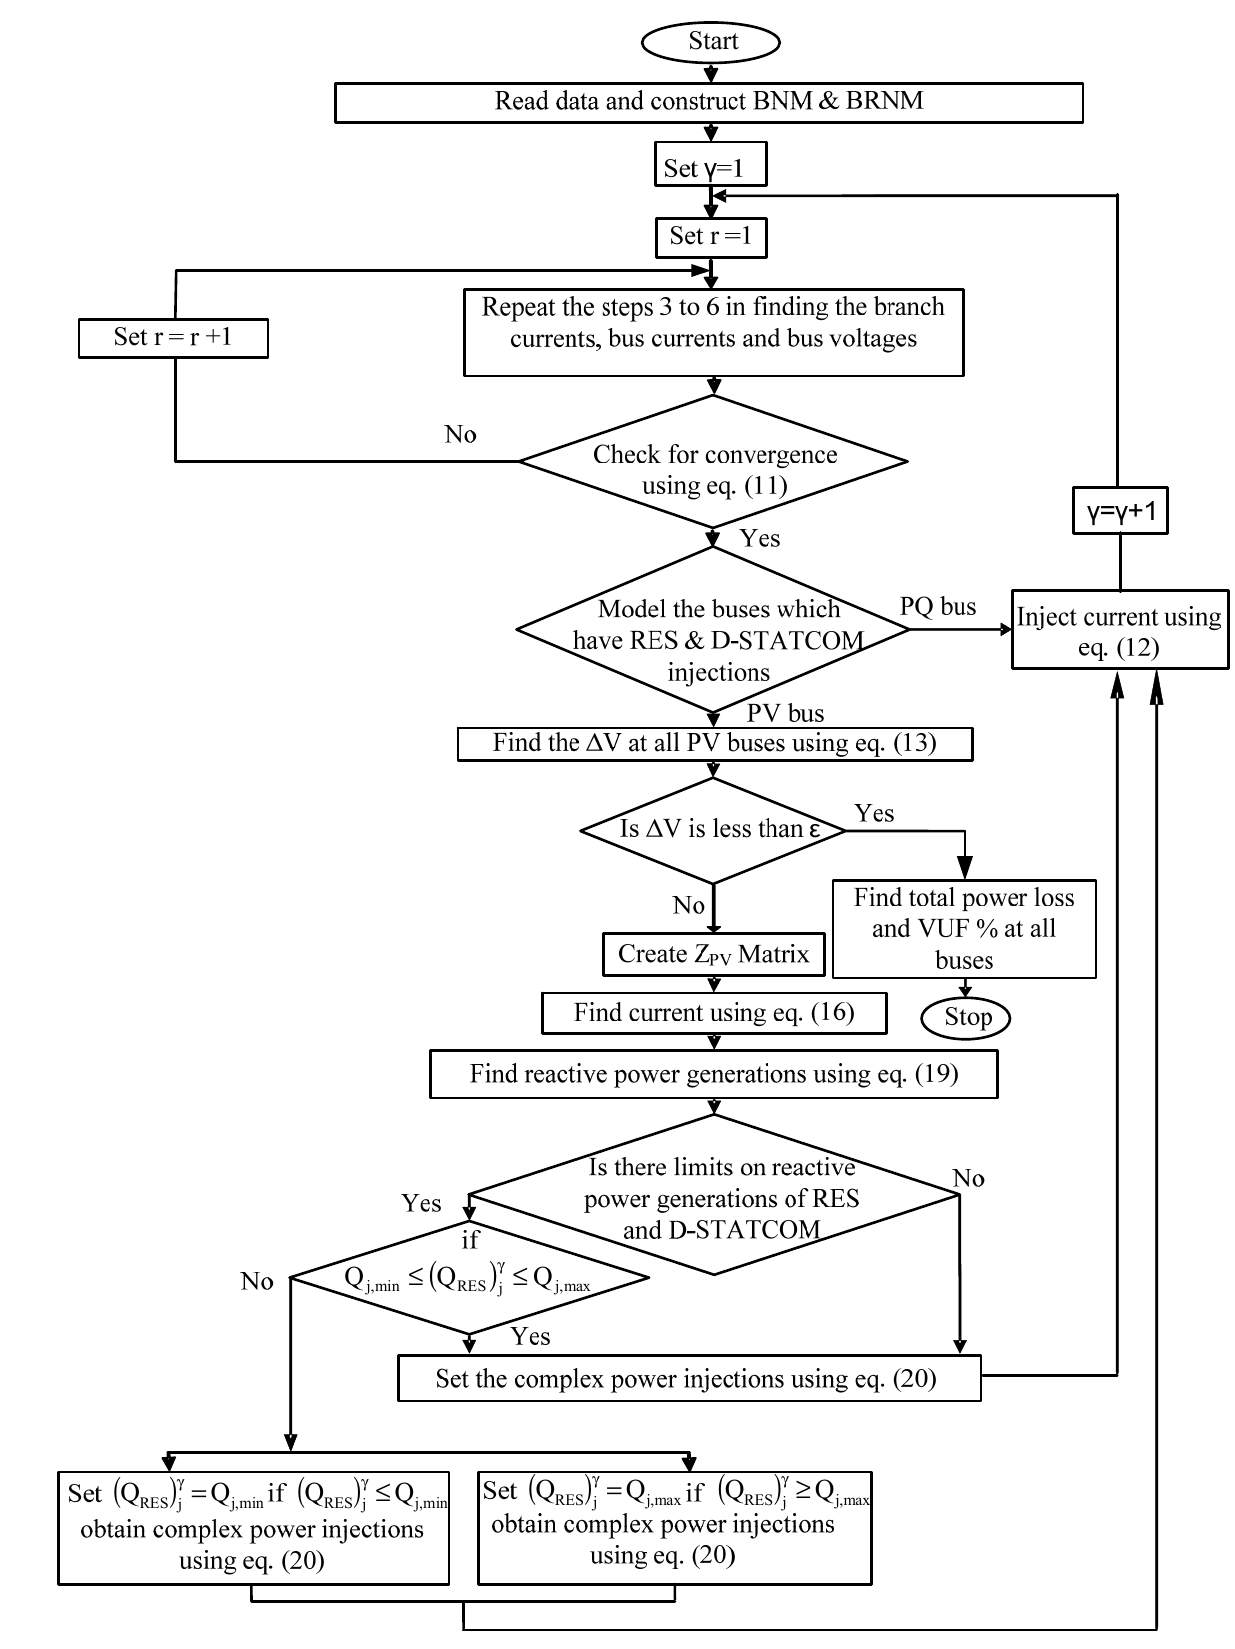
Figure 6. Flowchart for the proposed three-phase PFA.